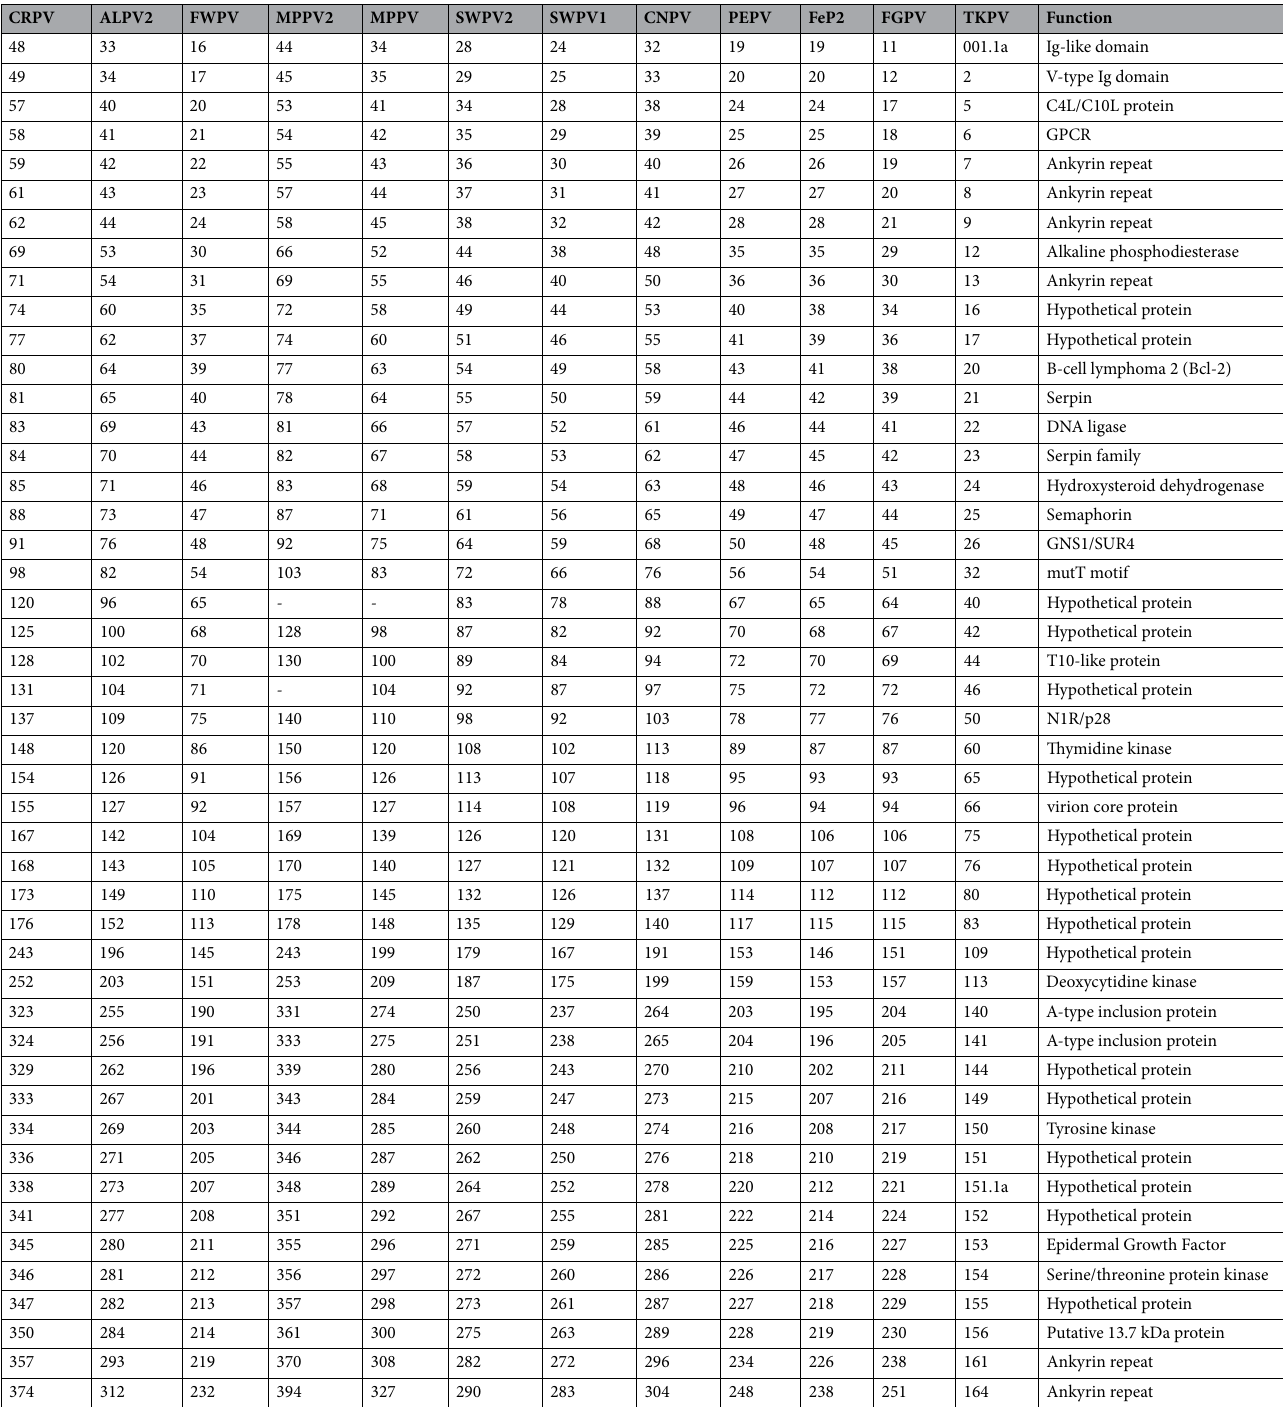
Table 2. 47 ORFs found to be uniquely conserved in the selected fully sequenced avian poxvirus genomes. The numbers in each column refer to the specific ORF in each respective